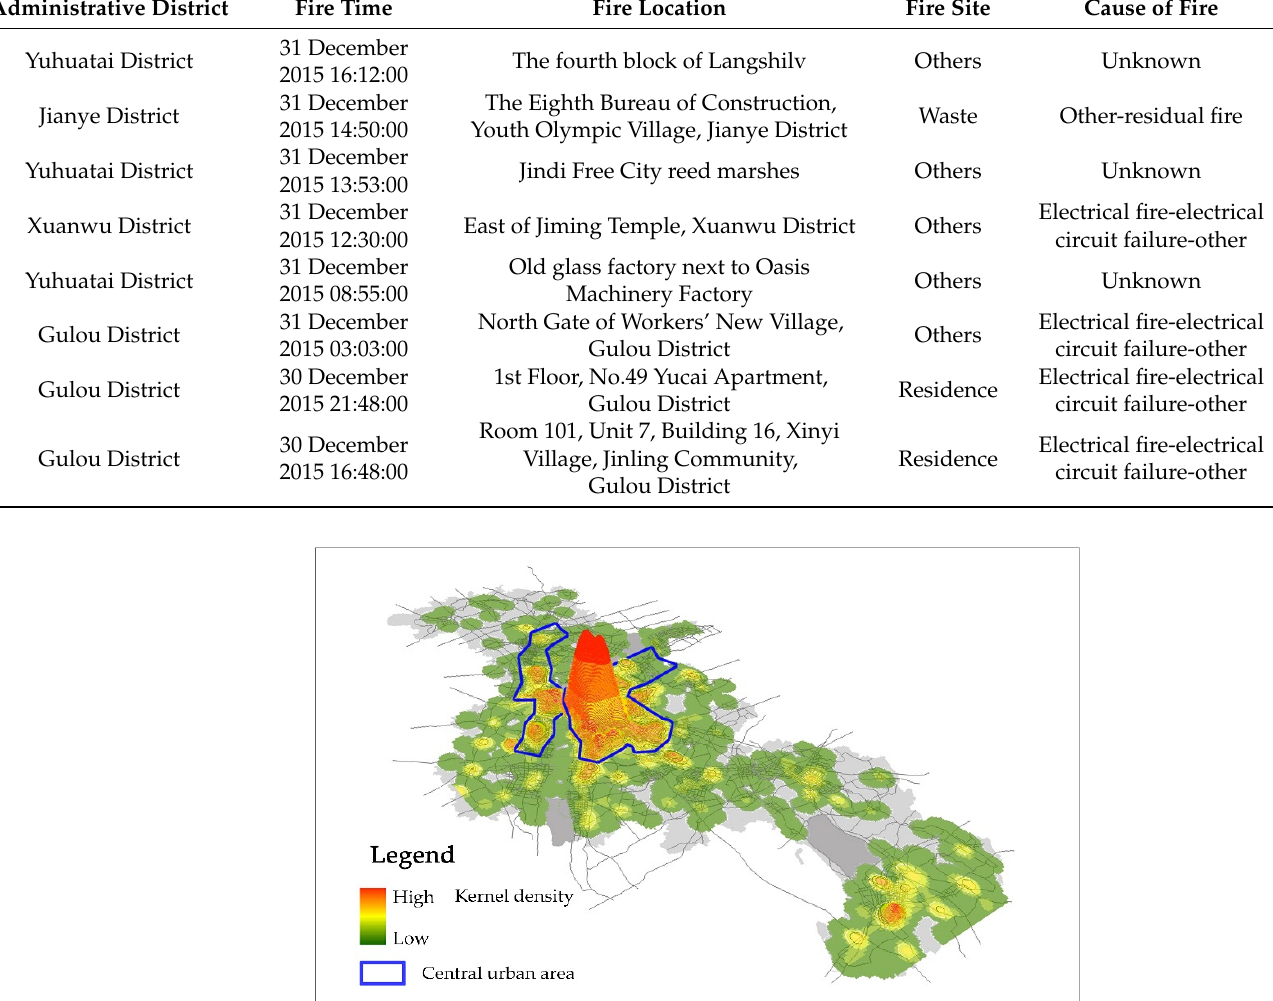
Table 1. Example of GPS data for emergency service events.